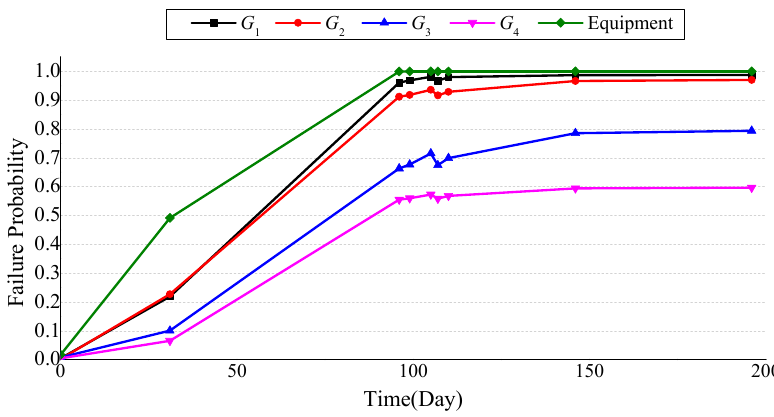
Figure 10. The result of failure probability calculation.